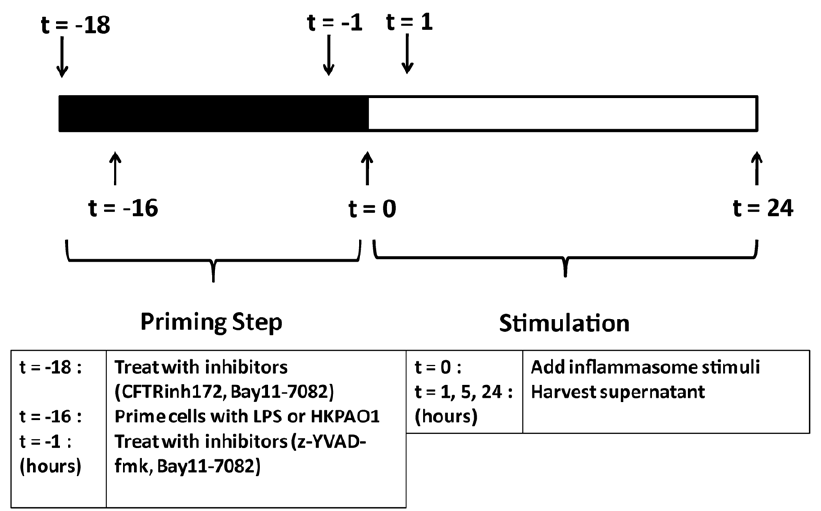
Figure 1. Cell stimulation and inhibitor schedule. Schedule outlines the timing of inhibitor addition and priming in relation to inflammasome stimulation (t=0) for THP-1 reporter and PBMC cytokine quantification experiments. Inhibitor treatments and stimulations were carried out as described in the Materials and Methods section.